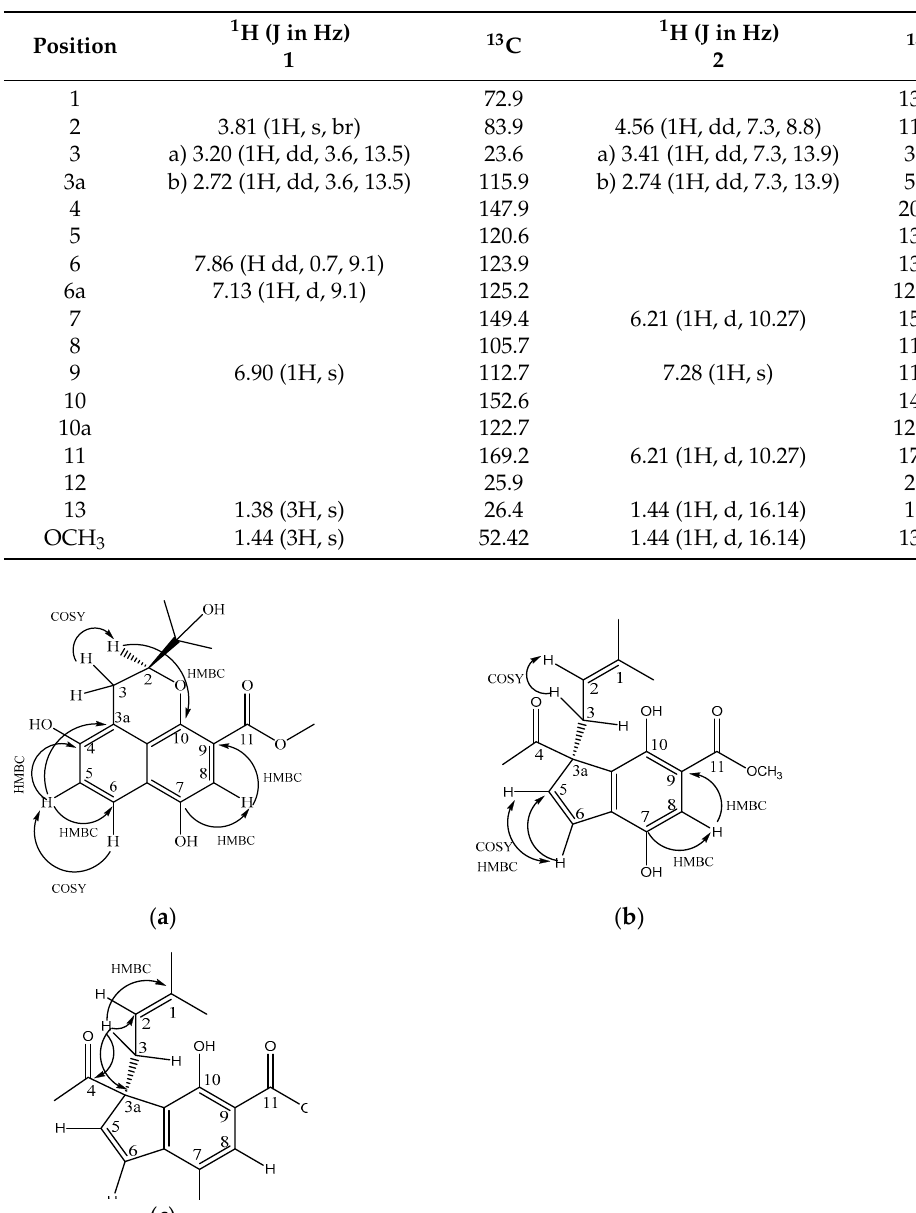
Table 1. 1 H-NMR and 13 C-NMR spectroscopy data of 1 (CD 3 OD, 400 MHz) and 2 (DCl 3 , 600 MHz).